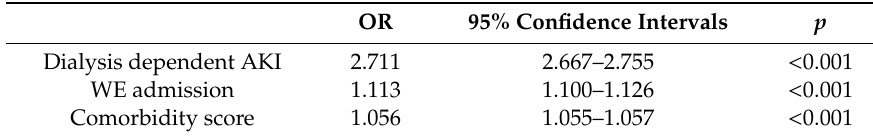
Table 5. Logistic regression analysis showing factors independently associated with in-hospital mortality. OR: Odds Ratio; 95%CI: 95% confidence intervals; WE: